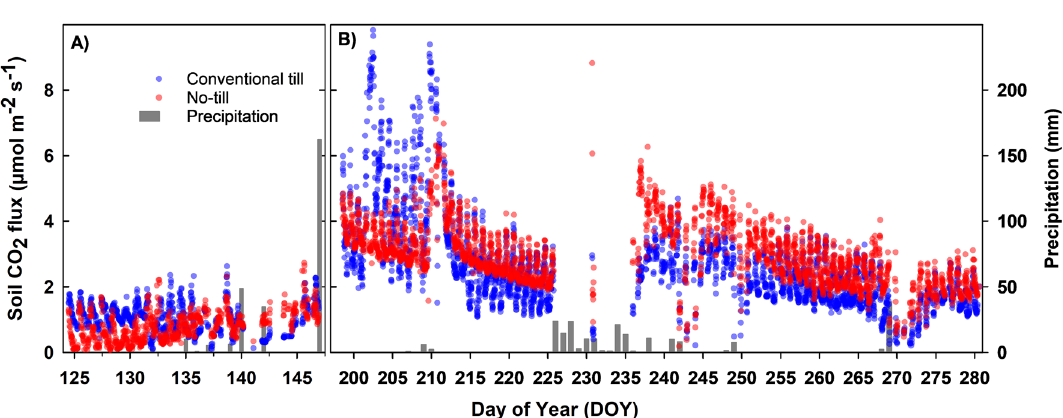
Figure 5. Frequency histogram of half-hourly soil CO 2 flux data from (A) wheat and (B) soybean under conventional tillage and no-tillage.